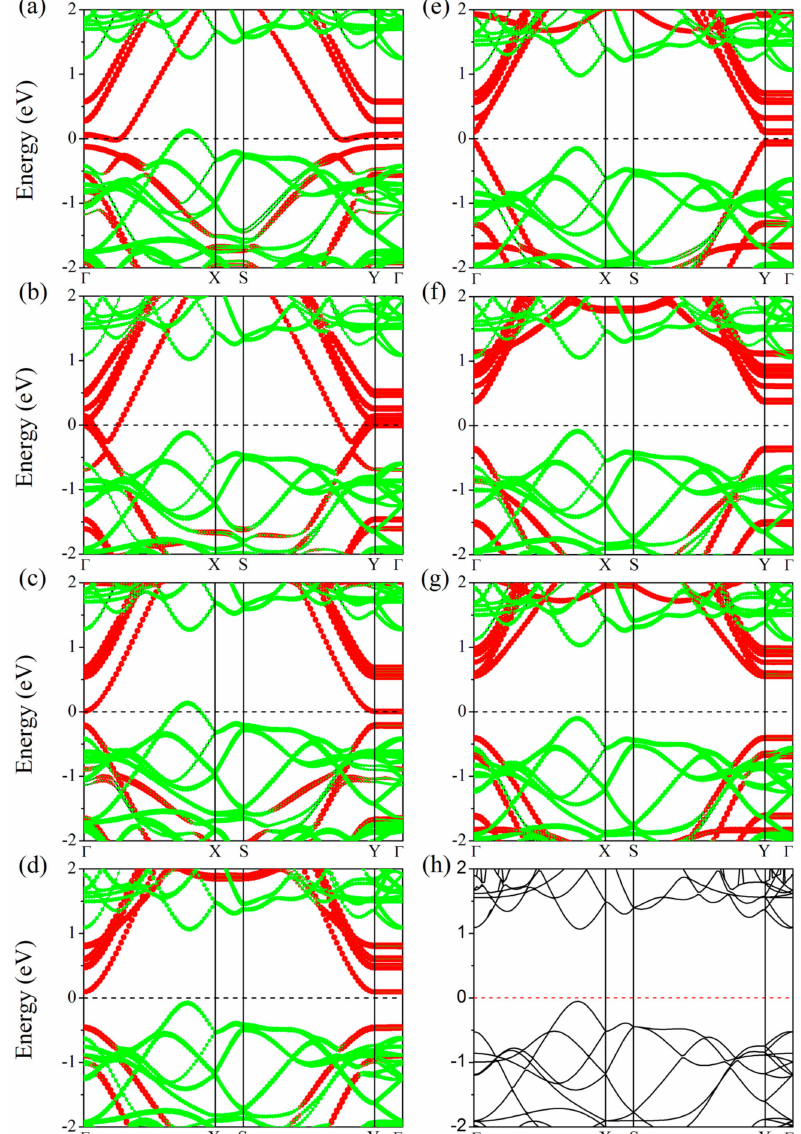
Figure 4. Projected band structures of ( n ,0)CNT/GeSe hybrids with n = ( a ) 5, ( b ) 6, ( c ) 7, ( d ) 8, ( e ) 9, ( f ) 10, and ( g ) 11. The red and green circle size denotes the weight of the CNT and monolayer GeSe in the CNT/GeSe configuration band structure. ( h ) is the band structure of pristine 2D GeSe calculated for comparison. A horizontal dashed line represents the Fermi